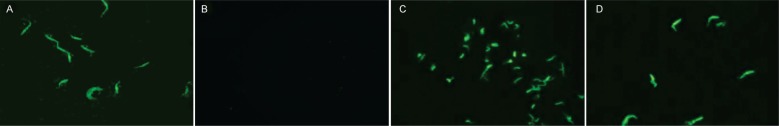
presence of Trypanosoma cruzi-specific IgG antibodies in the serum of sexually infected mice. Immunofluorescence of T. cruzi forms treated with mouse serum. The apple-green fluorescence was developed with a fluorescein-labelled secondary antibody against mouse anti-T. cruzi IgG. (A) Positive control, intraperitoneally infected mice. (B) Uninfected negative control. (C) Naïve male mice after mating with infected female mice. (D) Naïve female mice after mating with infected male mice.